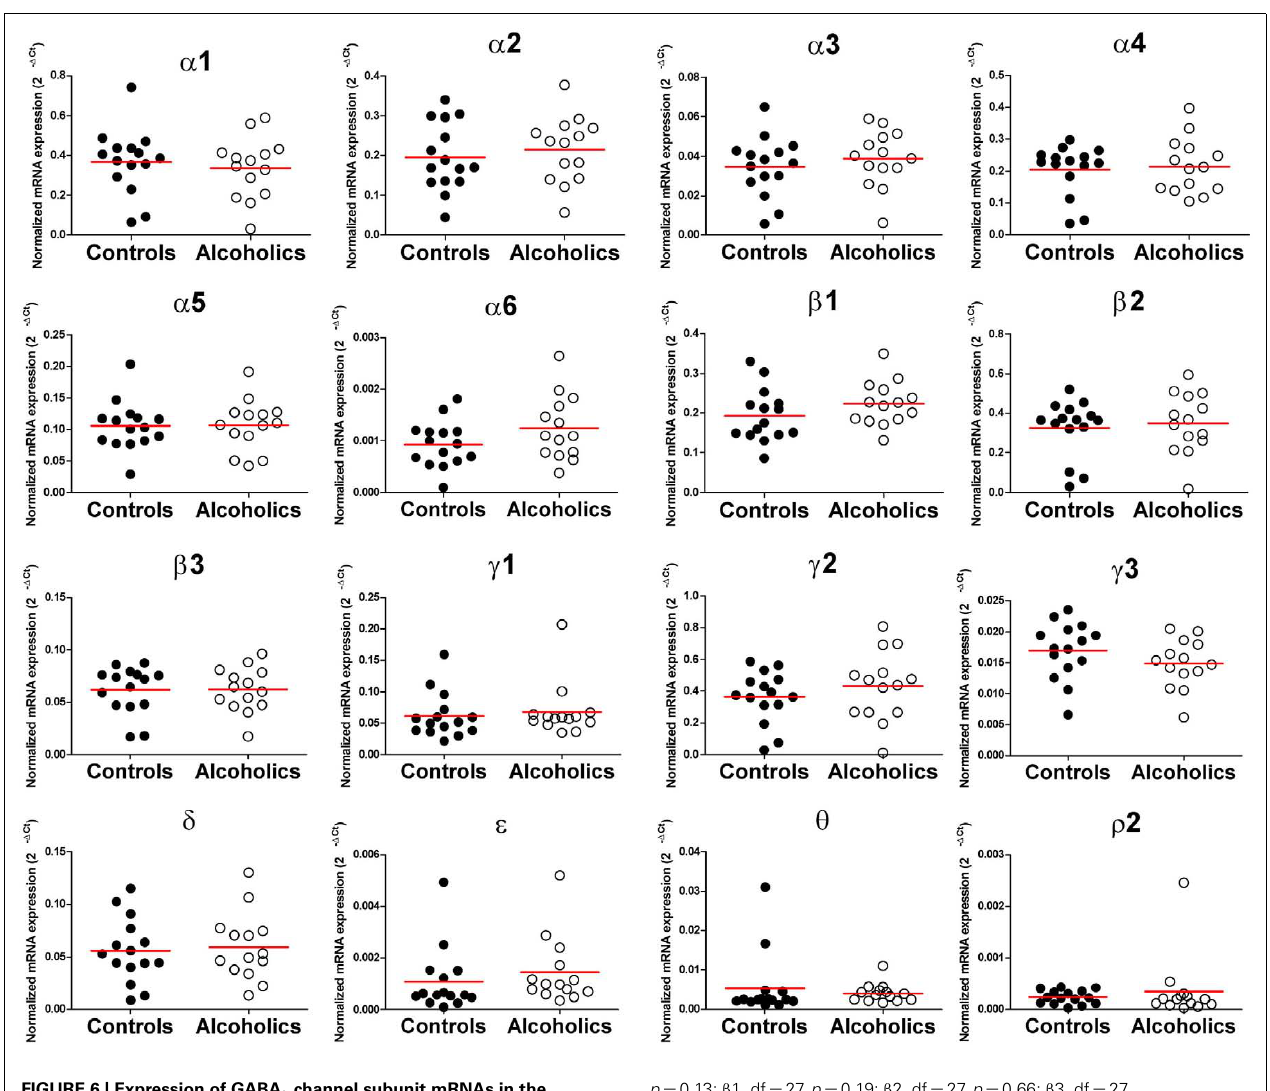
FIGURE 6 | Expression of GABA A channel subunit mRNAs in the prefrontal cortex of controls ( • , n = 15) and alcoholics ( ◦ , n = 14). Horizontal lines represented mean levels. One way ANOVA with Bonferroni post hoc test, α 1, df = 27, p = 0.58; α 2, df = 27, p = 0.55; α 3, df = 27, p = 0.45; α 4, df = 27, p = 0.76; α 5, df = 27, p = 0.93; α 6, df = 27,